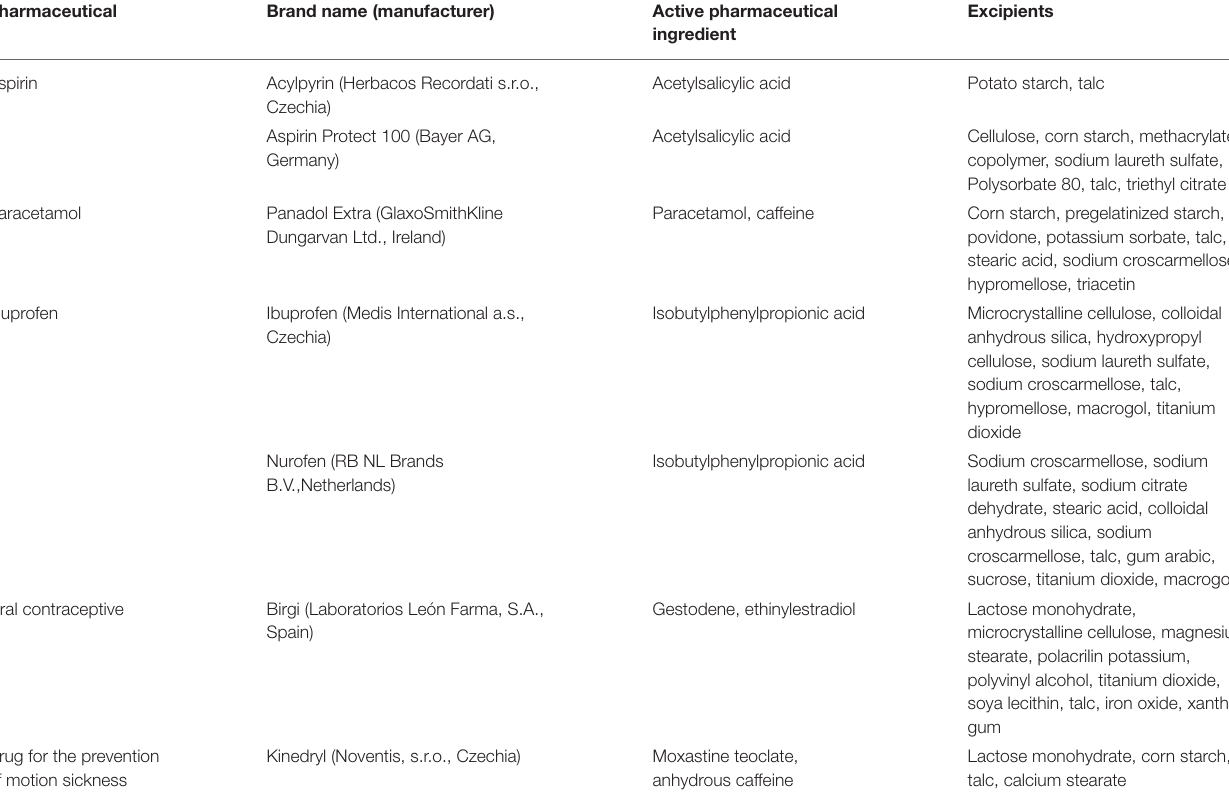
TABLE 1 | List of the used pharmaceutical drugs and their composition. The data were taken from the patient information leaflets.